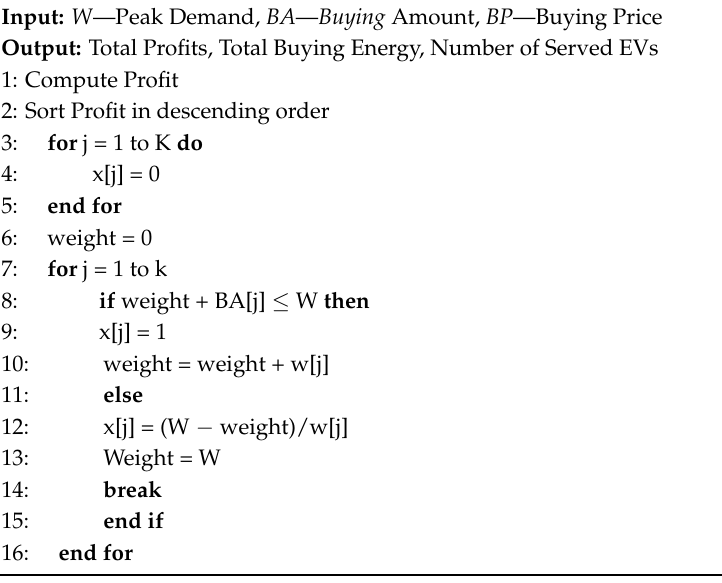
Algorithm 2. Market Mechanism for Charging-Buyer Vehicles (BEVs)